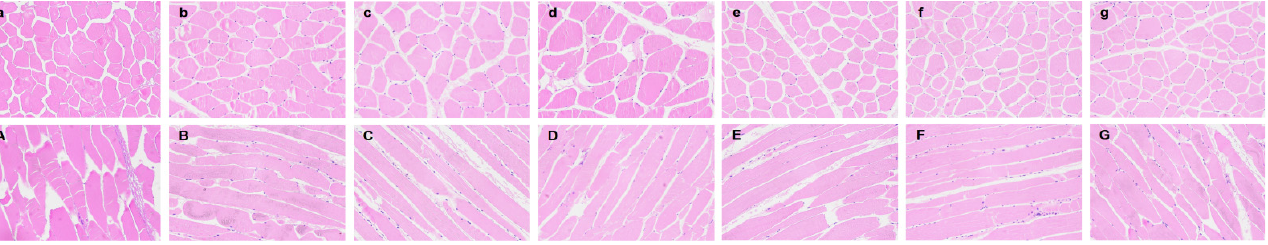
Figure 3. Light microscopy images of spiced beef under different thermal treatments at 200× mag- nification. ( a )–( g ) Transverse sections of myofibrils of the CT, SV, USV40, USV60, USV80, USV100, and USV120 treatment, respectively; ( A )–( G ) Longitudinal sections of myofibrils of the CT, SV, USV40, USV60, USV80, USV100, and USV120 treatment, respectively.